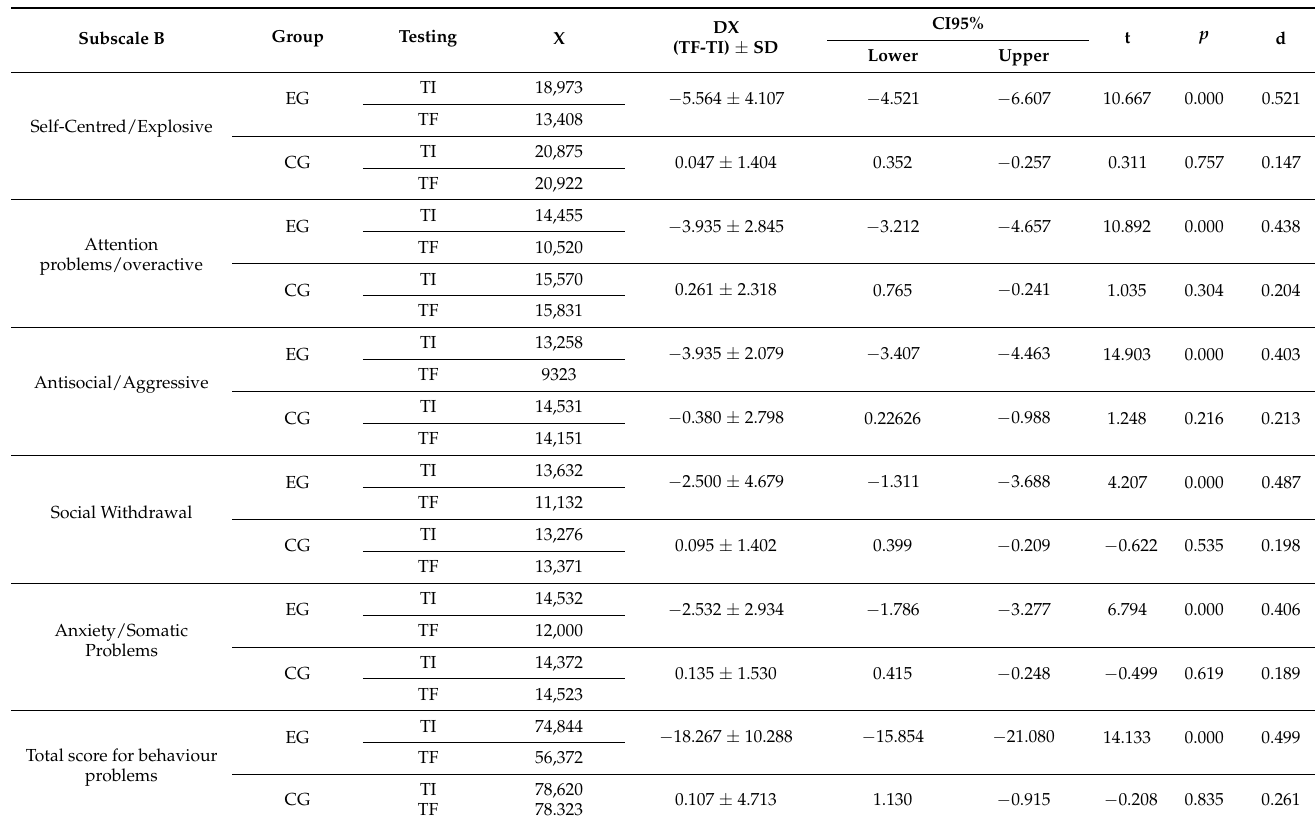
Table 5. Centralizer results according to the assessment of behaviour problems—Scale